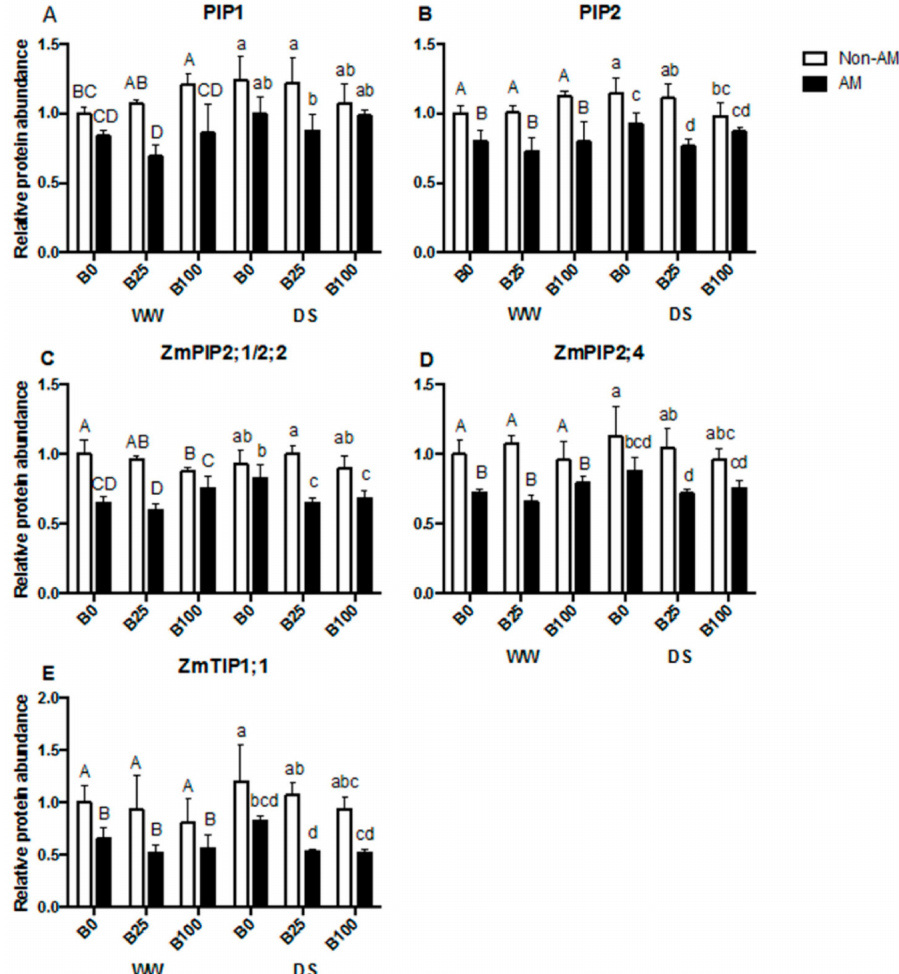
Figure 6. Relative protein abundance for PIP1 ( A ), PIP2 ( B ), ZmPIP2;1 / 2;2 ( C ), ZmPIP2;4 ( D ) and ZmTIP1;1 ( E ) in the microsomal fraction of roots from plants inoculated or not with the AM fungus R. irregularis , grown under di ff erent B concentrations (0, 25 or 100 µ M B) and submitted to two water regimes (well-watered [WW] or drought stress [DS]). Data indicate the mean ± SE for three biological replicates. Di ff erent letters indicate significant di ff erences between treatments ( p < 0.05) based on Duncan’s